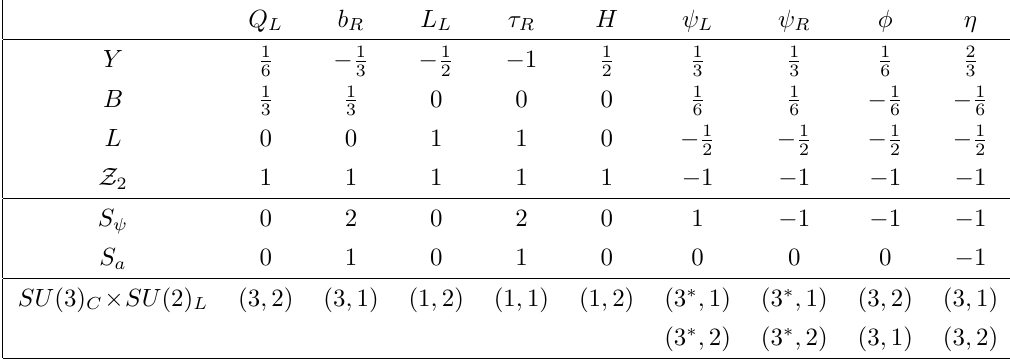
Table 4. Quantum numbers of the fields for the minimal Class 1 combined models. The last two lines list the models containing only singlets and fundamentals under the SM gauge group.